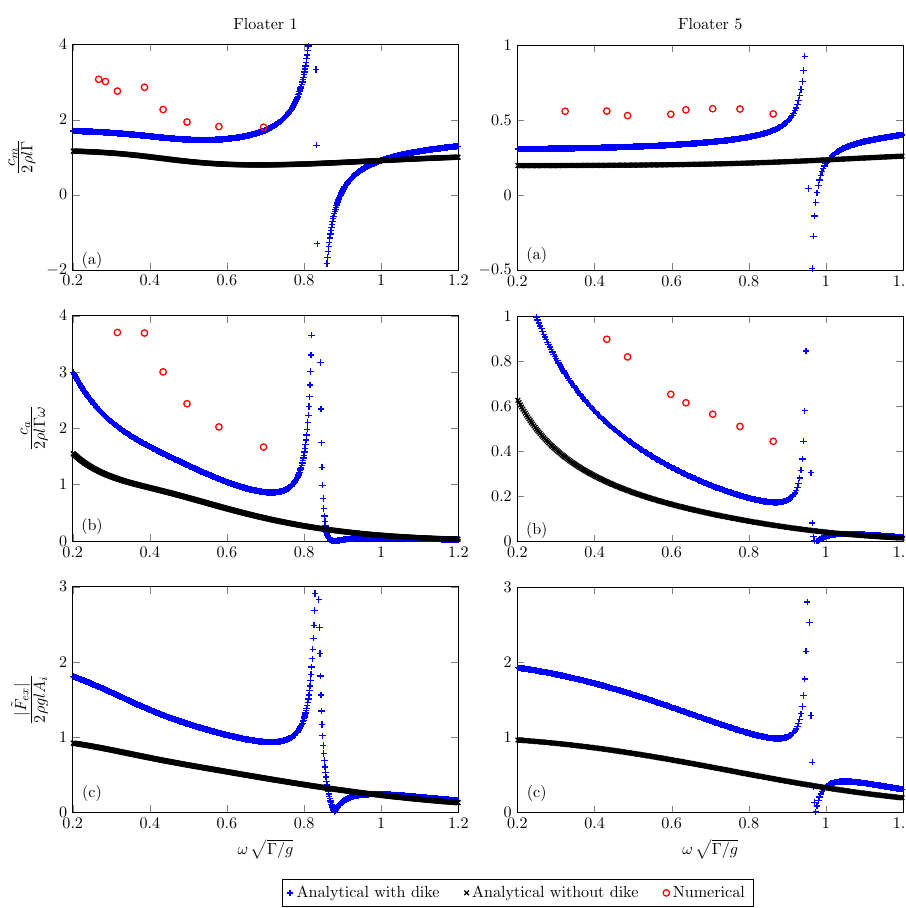
Figure 6. Analytical hydrodynamic coefficients with and without the dike, from top to bottom: added mass, damping coefficient and excitation force. Numerical radiation coefficients are also represented for floaters 1 and 5.